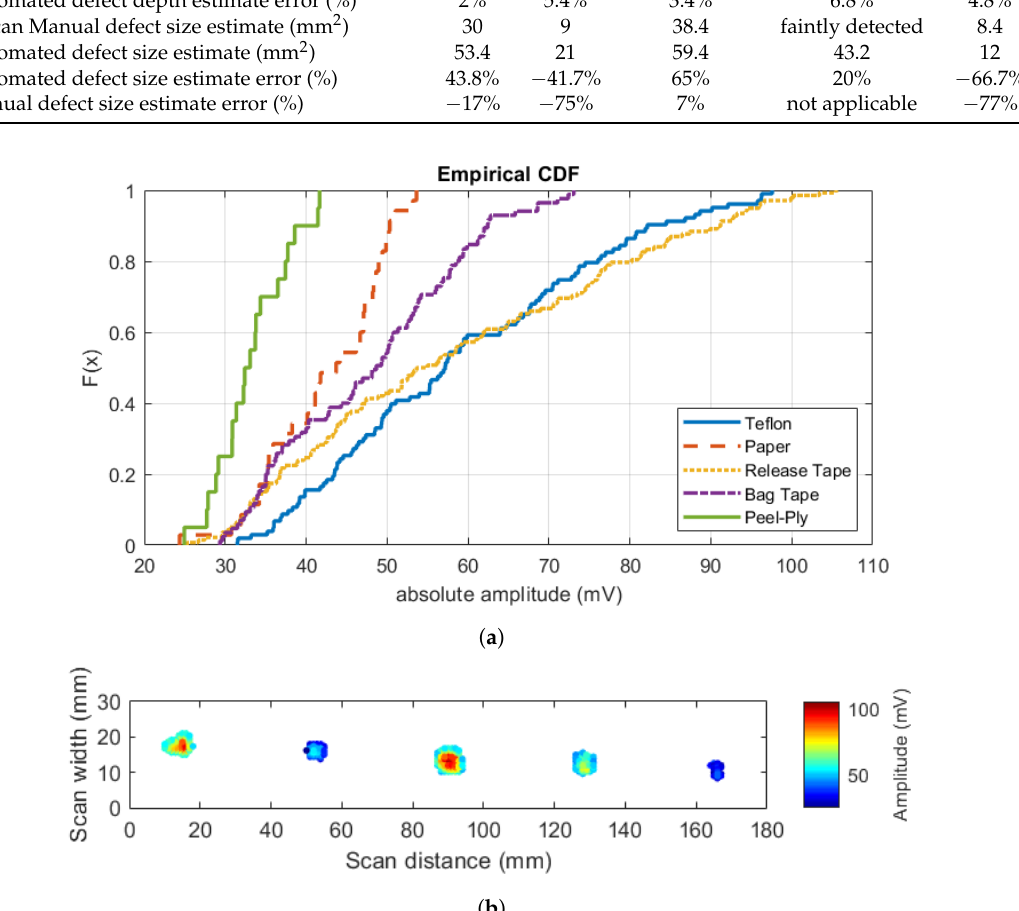
Figure 14. ( a ) Empirical CDF of absolute peak of defect echoes, and ( b ) refined size estimation after resizing defects with a wide range of amplitude